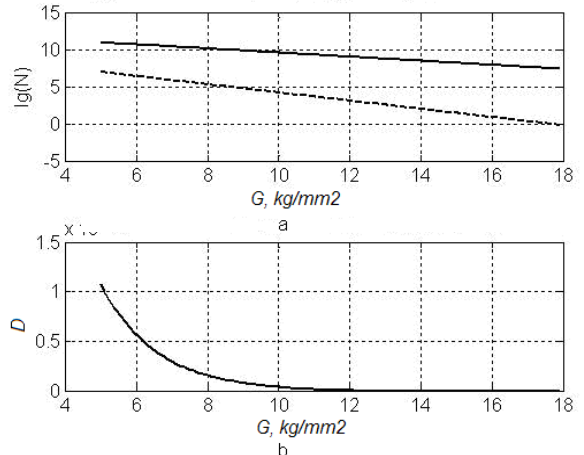
Fig. 3. The change of first model per full cycle: а – stress range and durability characteristics lg( N ) = f ( σ ) + S σ b − damage range of a full cycle D = f ( σ ) + S σ Figure 4 shows the same characteristics for quadratic 2 -1.4892 σ variation lg( N S ) = 0.03477 σ +15.669) мах мах and stress limit lg( N D )=23.4151-5.6135 ln( σ ), calcu- 2 мах